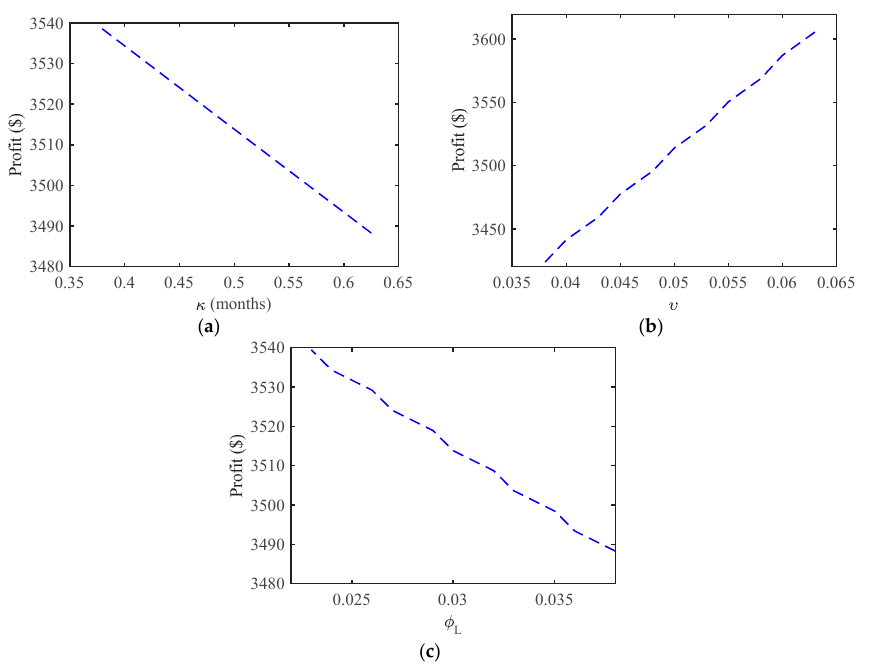
Figure 8. Total profit profile associated with single payment-based payment in advance parameters. ( a ) describes the total profit against different lead times, ( b ) describes the total profit for different discount rates due to instalment-based payment in advance, and ( c ) shows the profit vs. interest rate on the loan amount. Example 3. (Case I) All the parameters are the same as Example 1. Some additional parameters